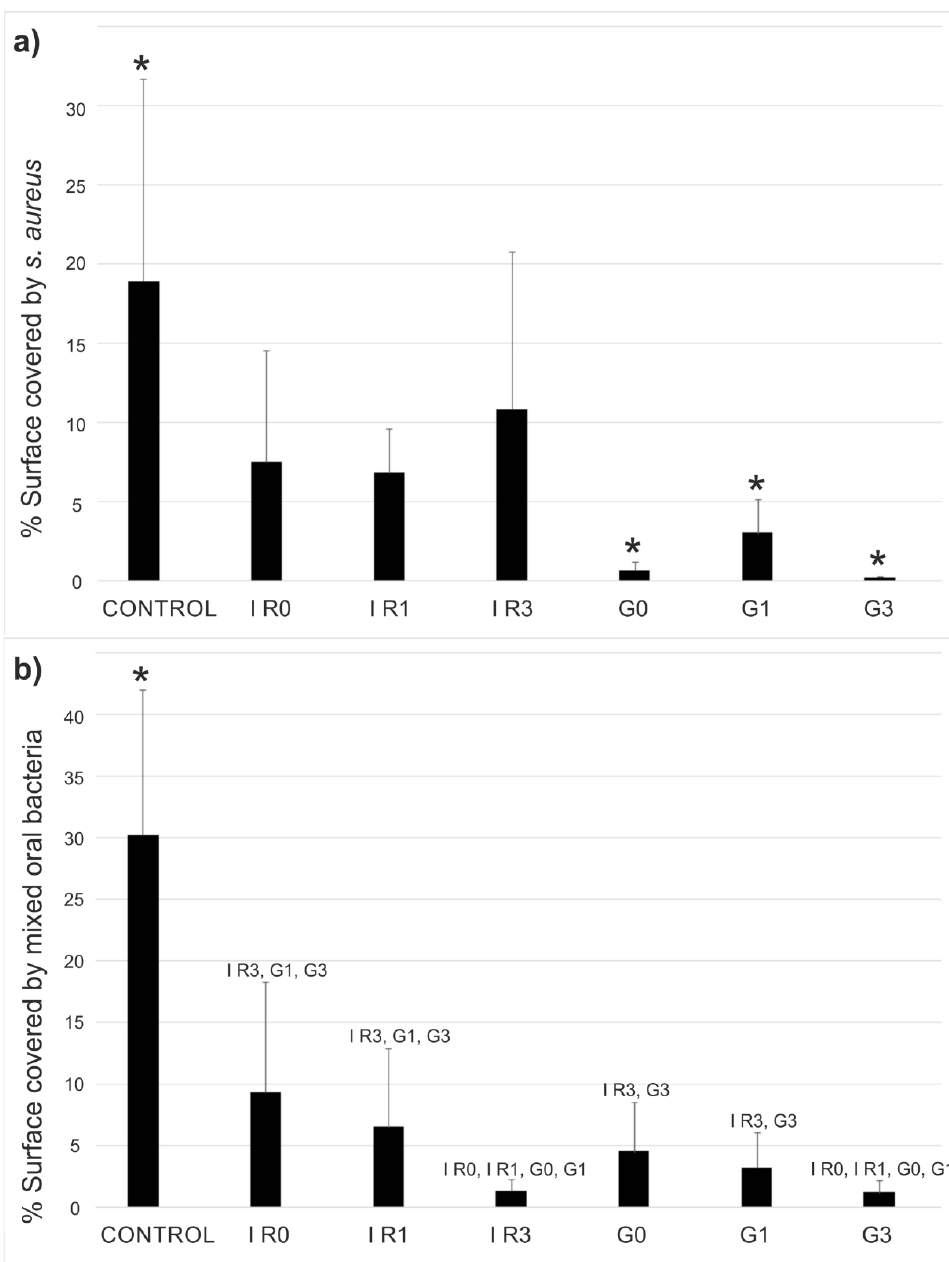
Figure 9. Bacterial adhesion. Results are given in mean percentage of titanium surface covered with ( a ) S. aureus or ( b ) mixed oral bacteria after 90 min of incubation. Control sample is the bare titanium disc without Ag-NPs. The other samples correspond to Ti discs with immobilized Ag-NPs obtained according to conditions of Table 3. The error bars represent the standard deviation (* p < 0.05 with respect all the other materials). The adhesion results indicate that S. aureus and mixed oral bacteria showed lowered adherence to the titanium discs with immobilized Ag-NPs compared to untreated tita- nium surface ( p ≤ 0.01). The incorporation of silver NPs resized by the green-nanosecond laser (Figure 9a sample G3) was more effective to inhibit the bacterial adhesion to the titanium surfaces, than using the IR-picosecond laser to re-irradiate the Ag-NPs (Figure 9a sample IR3). The Ag-NPs re-irradiated three times using the Green-nanosecond laser (samples G3) and immobilized on the Ti discs produced a higher anti-adherent effect ( p ≤